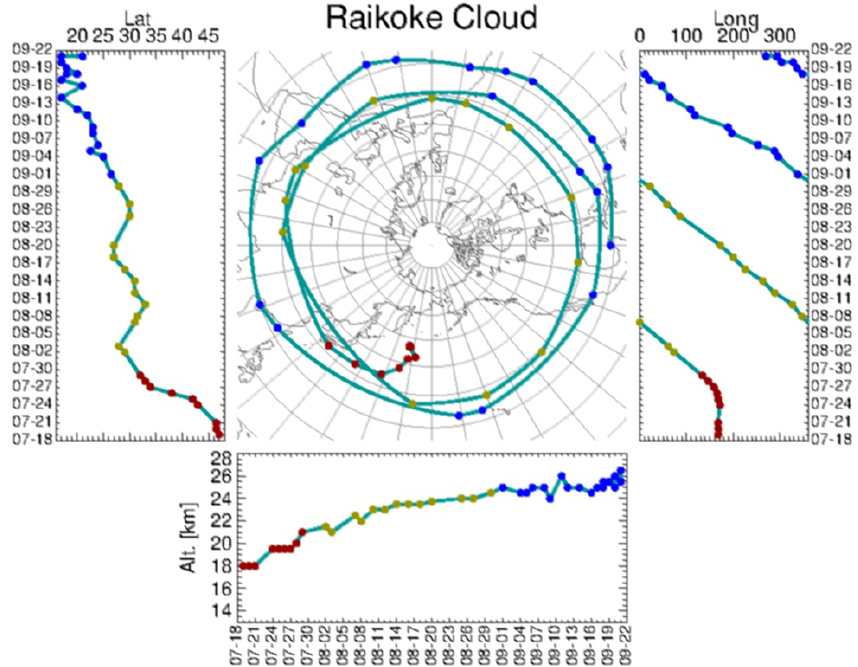
Figure 17. The observed path of the CCC as inferred from OMI/OMPS/TROPOMI and CALIOP observations. The individual observations are shown by dots color-coded by